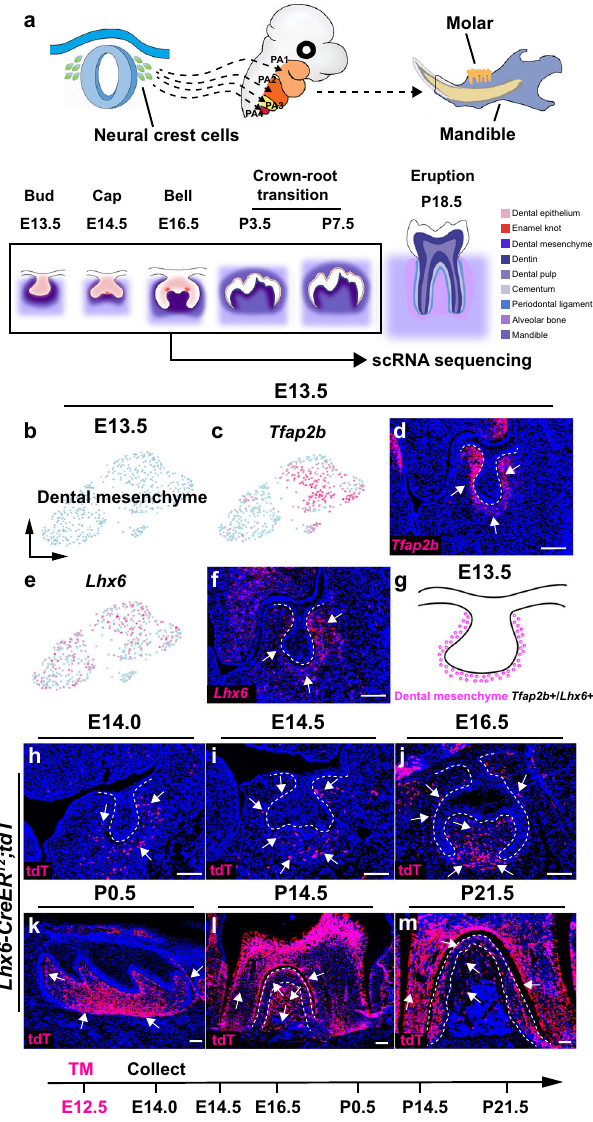
Fig. 1 | Dental mesenchymal cell populations are relatively homogenous at E13.5. a Schematic drawings illustrating the experimental design in this study. b UMAP plot of the cell cluster of the dental mesenchyme in the mouse molar at E13.5. c – f Feature plot and RNAscope staining of Tfap2b and Lhx6 in the mouse molar at E13.5 ( n =3). g Schematic drawing of the cellular domain in the dental mesenchyme of the mouse molar at E13.5. h – m Lineage tracing experiment with Lhx6-CreER T2 ;tdT mouse molars ( n =3). Injection protocol is illustrated underneath the fi gures.Whitedottedlinesin d , f , h , i and j outlinethedentalepithelialcellsand in l and m outline the PDL in the mouse molar. White arrows point to the positive signals. Scale bars, 100 μ